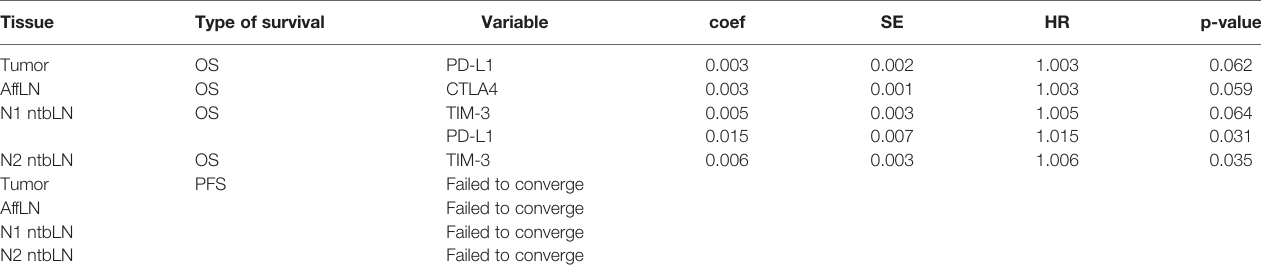
TABLE 3 | Immune cell exhaustion markers selected for the fi nal model of overall and progression-free survival using multivariate forward Cox regression.